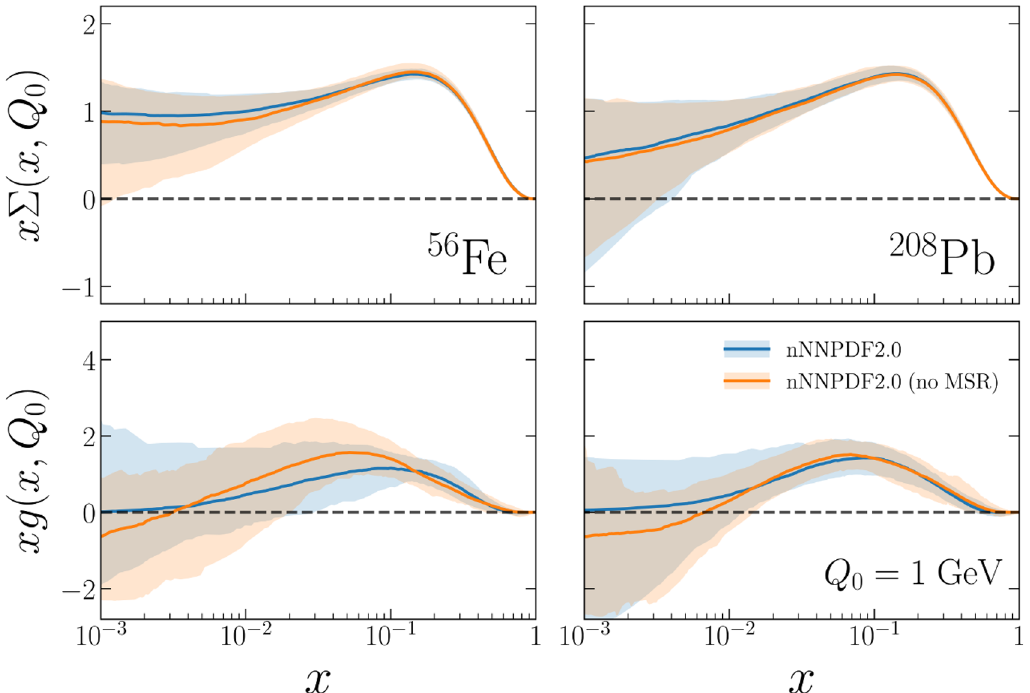
Figure 20 . Comparison of the baseline nNNPDF2.0 (cid:12)t at Q 0 = 1 GeV with the variant in which the momentum sum rule is not being imposed. We show the total quark singlet (left) and the gluon (right) for 56 Fe (upper) and 208 Pb (lower panels).